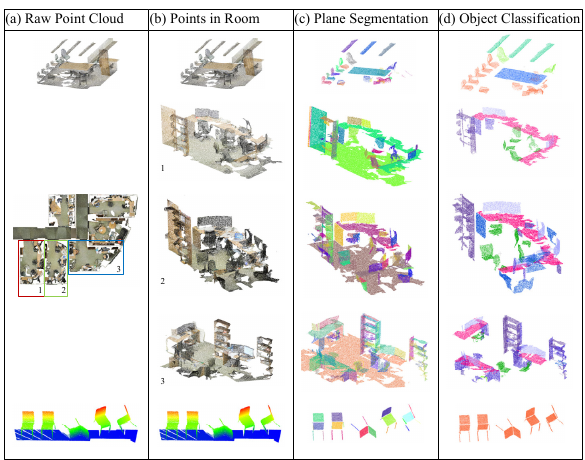
Figure 5. Qualitative results of indoor object classification. (a) Original data (certain datasets have the ceilings removed for clarity). (b) Side view of data in one room. (c) The patch